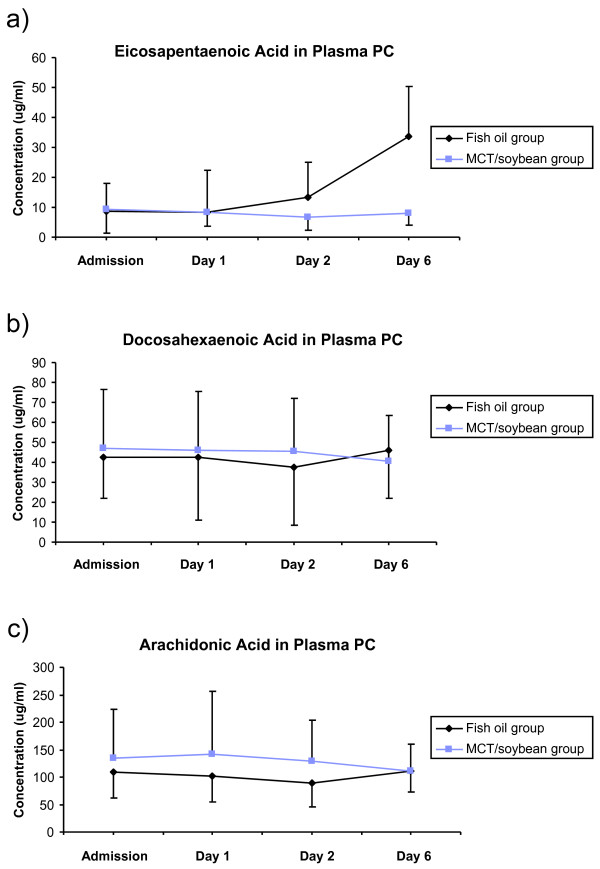
The concentrations (μg/ml) of (a) EPA, (b) DHA and (c) arachidonic acid in plasma phosphatidylcholine in the two treatment groups. *P < 0.001 vs. MCT/LCT at the same timepoint.